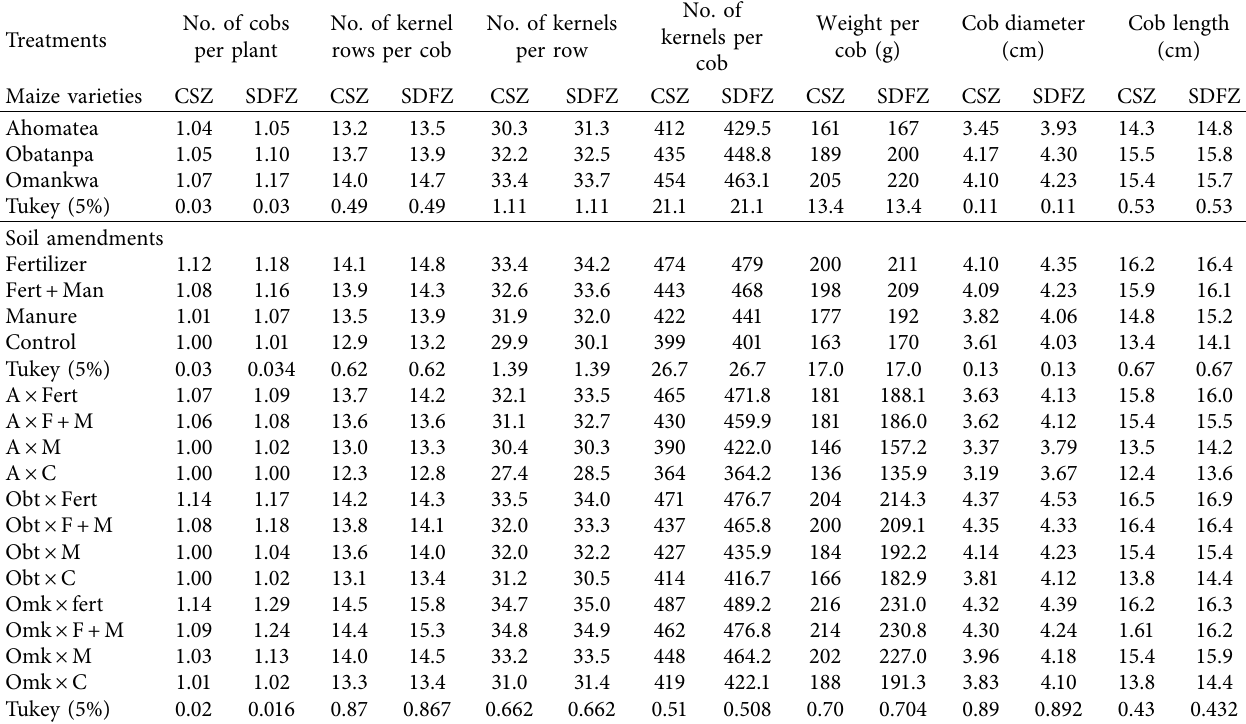
Table 8: Yield components of three maize varieties under four soil amendments in the coastal savannah zone (CSZ) and semideciduous forest zone (SDFZ) in the major cropping season.